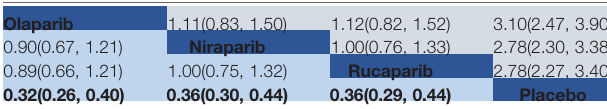
TABLE 3 | The network meta-analysis of PFS in the overall population.